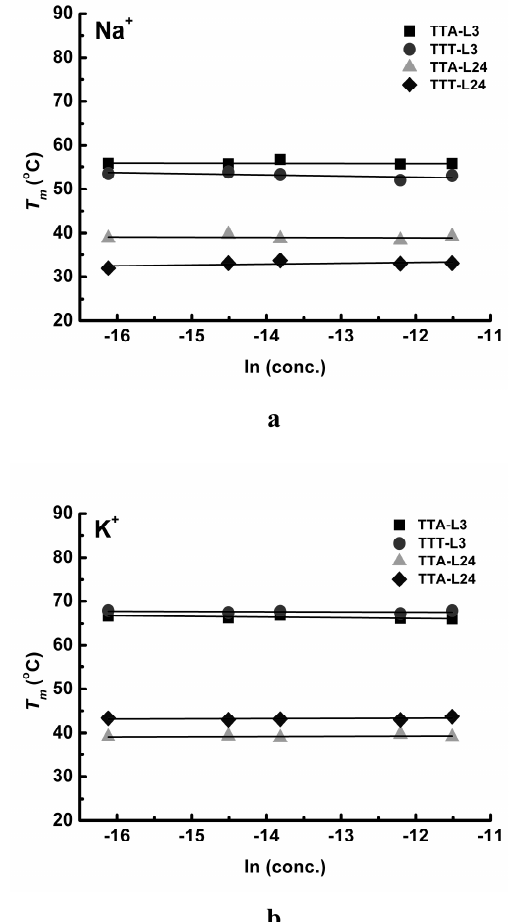
Figure 7. Concentration dependence of the Tm of TTA-L3 (triangle), TTA-L24 (circular), TTT-L3 (square) and TTT-L24 (diamond) in Na + ( a ) and K + ( b ) solutions, respectively. The concentrations of oligonucleotides are 0.1, 0.5, 1.0, 5.0, and 10.0 M.